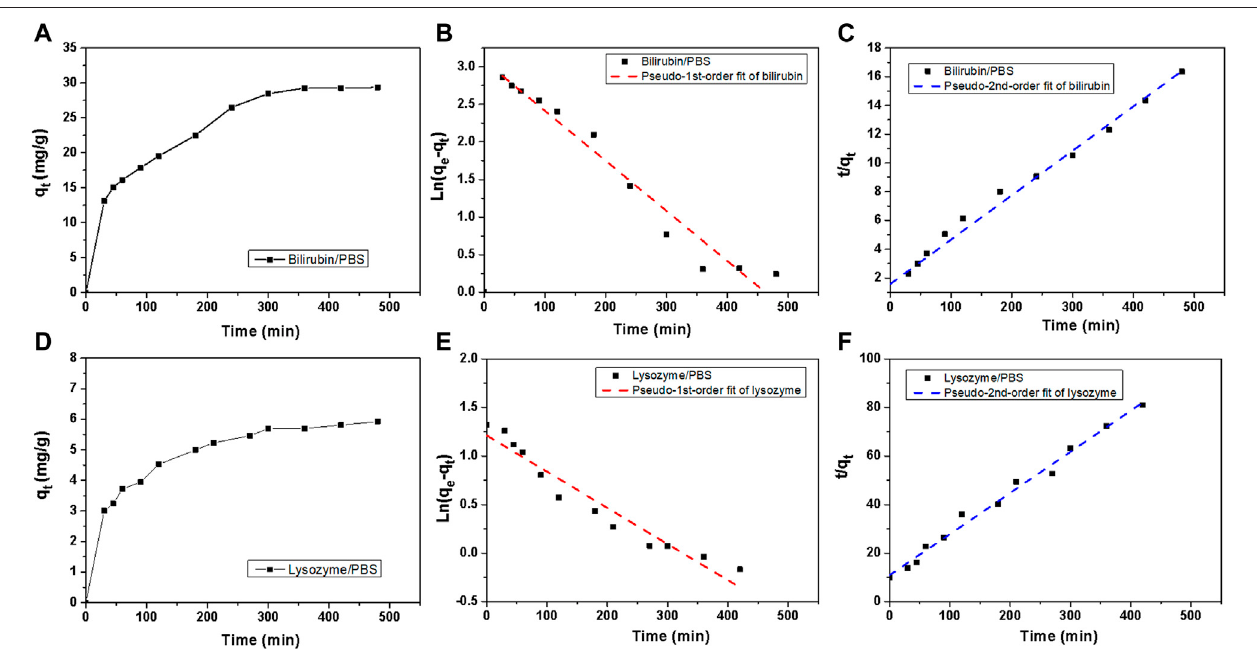
FIGURE 8 | Bilirubin and lysozyme adsorption kinetics of HCP(St-DVB-VP). (A,D) Toxin uptake versus times in PBS. (B,E) Adsorption kinetic pseudo-1st-order and (C,F) pseudo-2nd-order fi tting plots for bilirubin adsorption.